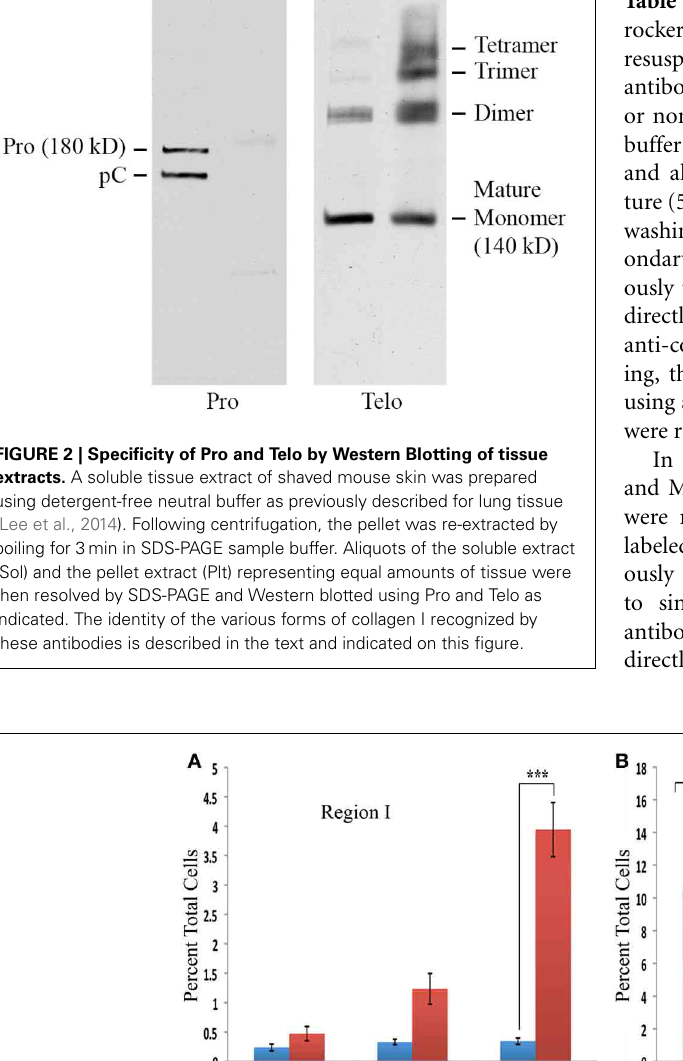
saline, 3; 10-day bleomycin, 3; 28-day saline, 18; 28-day bleomycin, 26. Because there was no difference between the percent of cells in Region II in saline and bleomycin lung at day 3 and at day 10, saline and bleomycin data were pooled before determining the statistical significance in the decrease in percent of cells in Region II between day 3 and 10. ∗∗ p < 0 . 01, ∗∗∗ p < 0 .